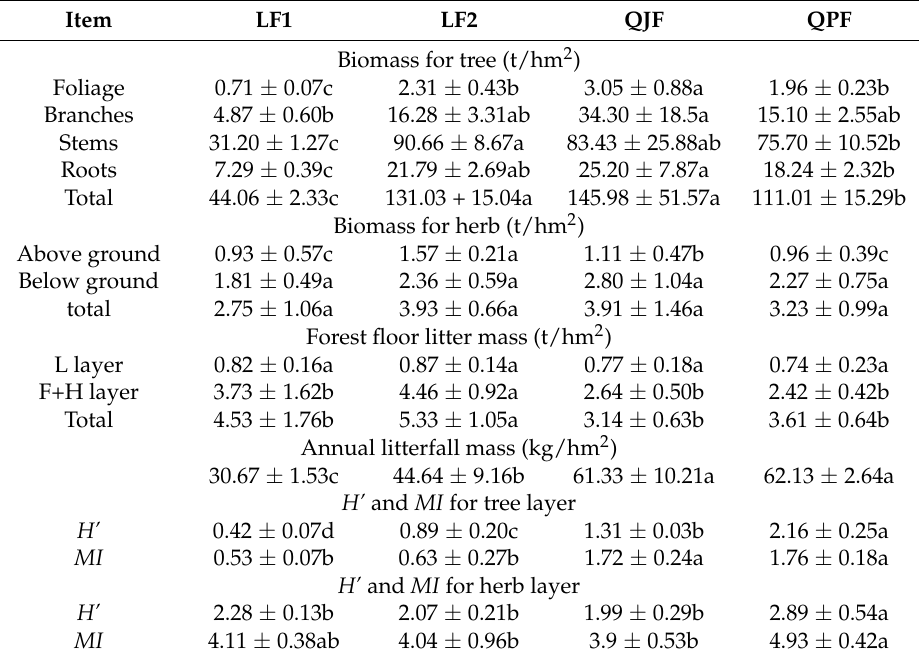
Table 3. Vegetation properties in different forest types (means ± SE, n = 3).